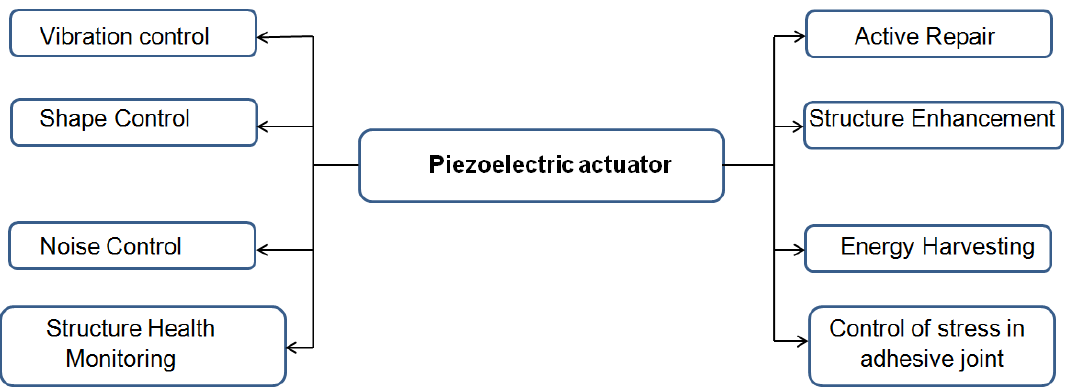
Figure 1. Classification of main piezoelectric material application.